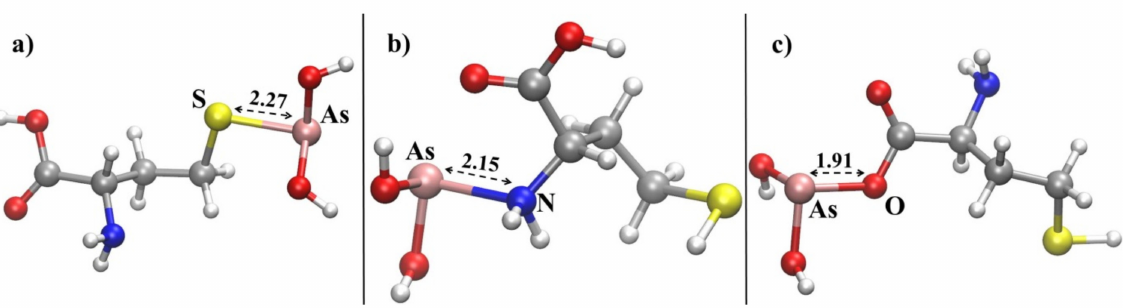
Figure 4. Molecular structures of the complexes formed by the direct one-to-one binding of As(III) with the thiol ( a ), amino ( b ), and carboxylic ( c ) groups optimized at the B3LYP/6-311++G(d,p) under implicit solvation. Relevant optimal interatomic distances are shown in